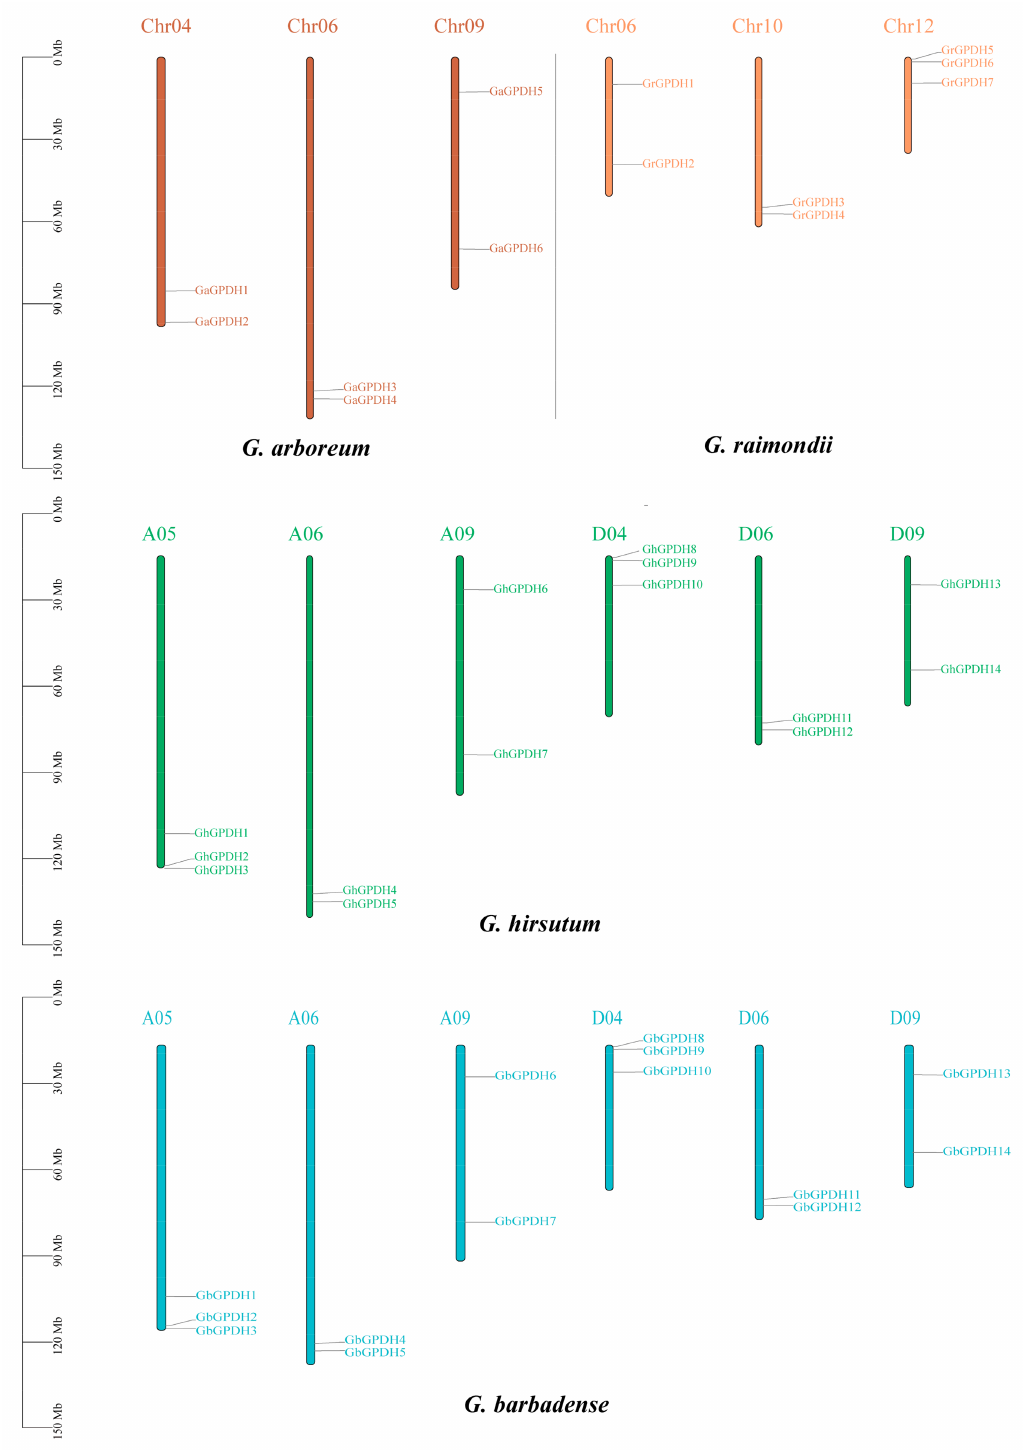
Figure 2. Distribution of cotton GPDH on chromosomes. The scale bar represents the length in megabases (Mb), and the different colors represent different cotton